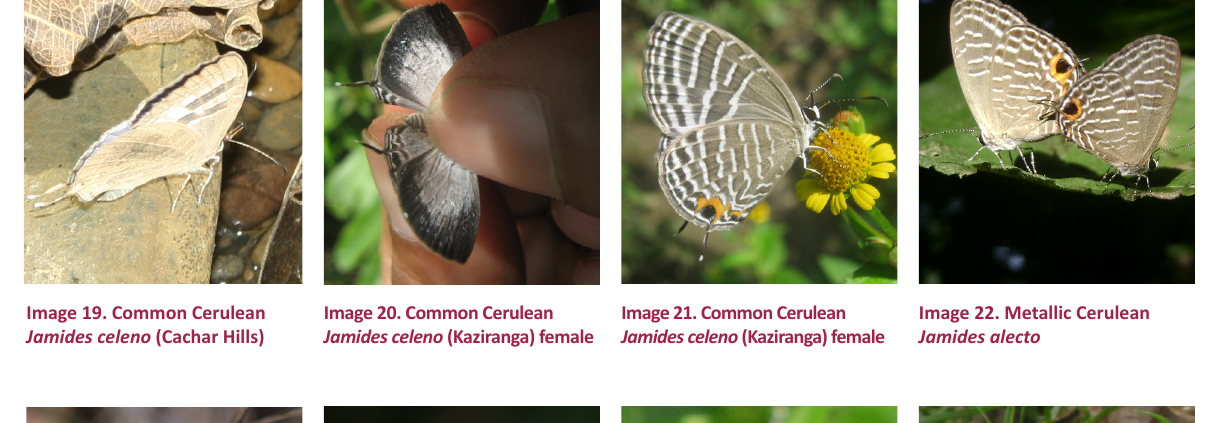
Image 19. Common Cerulean Jamides celeno (Cachar Hills)